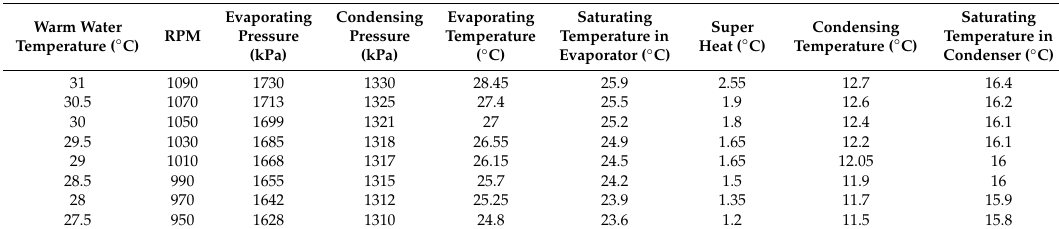
Table 5. Operating fluid pump RPM control range according to the surface water temperature (cold water temperature: 8.5 ◦ C).